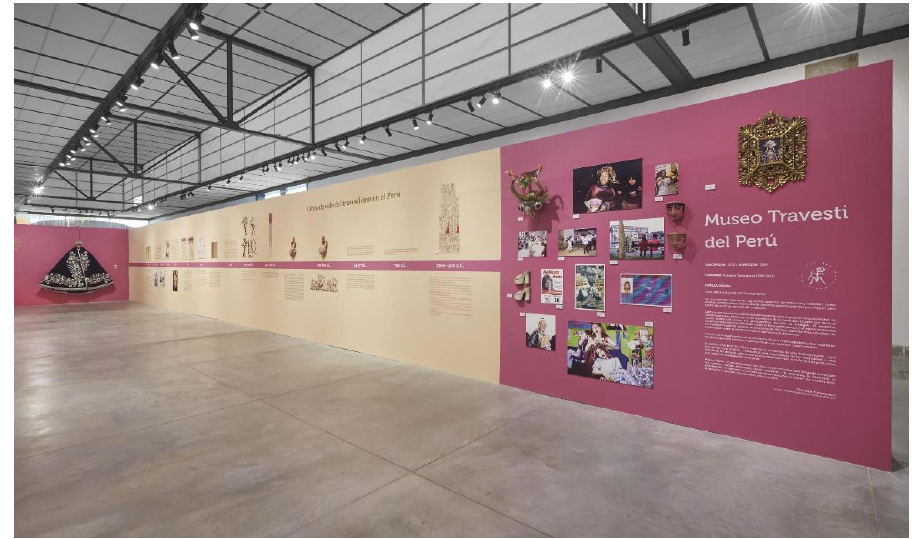
Figure 6. Giuseppe Campusano, Museo Travesti del Perú (2003). Museum Void: Half a Century of Peruvian Museotopies (1966–2016) installation view. Photo: Juan Pablo Murrugarra. Courtesy of MAC Lima.